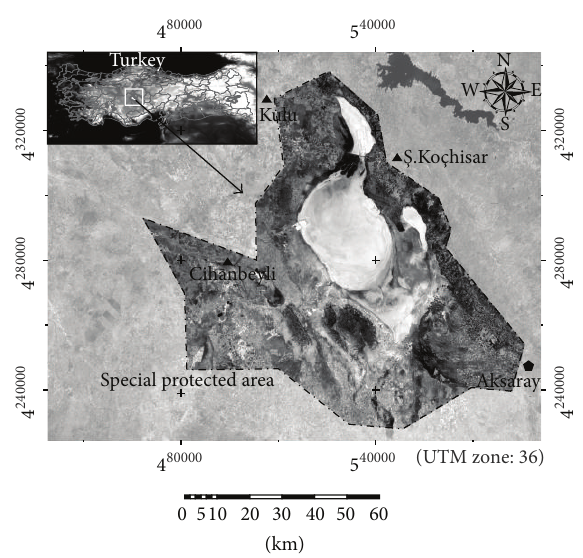
Figure 1: Location of the Salt Lake Basin (Turkey) through Landsat- 5 TM near infrared band (August